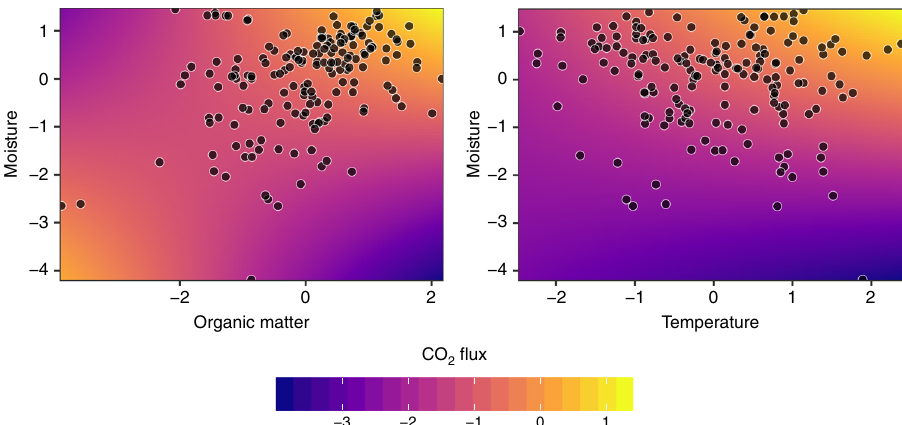
Fig. 3 Response of CO 2 fl uxes to environmental variables. Left, moisture against organic matter. Right, moisture against temperature. Original values of moisture (%), organic matter (%) and CO 2 fl ux (mmol m − 2 d − 1 ) are shown in a log 10 -transformed and z -transformed scale. Original values of temperature (°C) are shown in a z -transformed scale. Relationships arise from the linear mixed-effects model analysis.